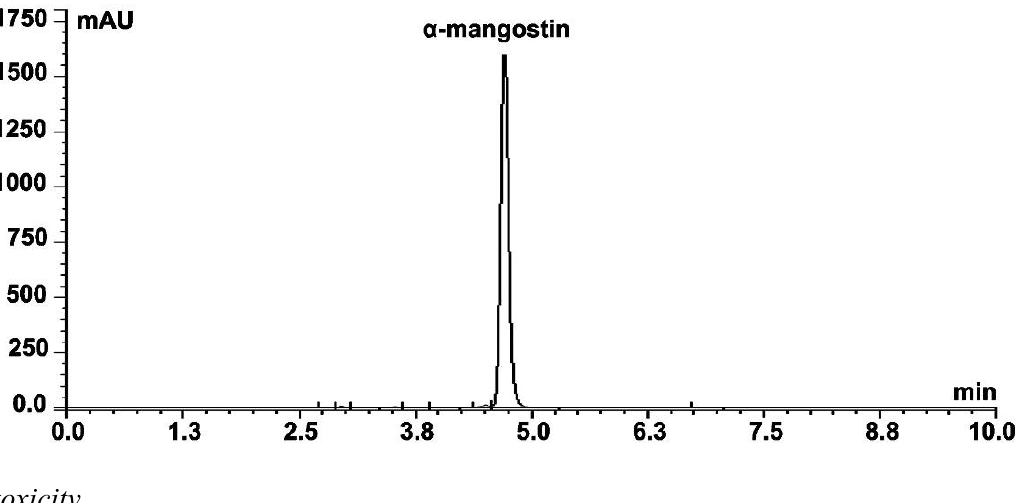
Figure 3. HPLC chromatogram of the isolated α -mangostin. Data collection was carried out at 244, 254, 316 and 320 nm.